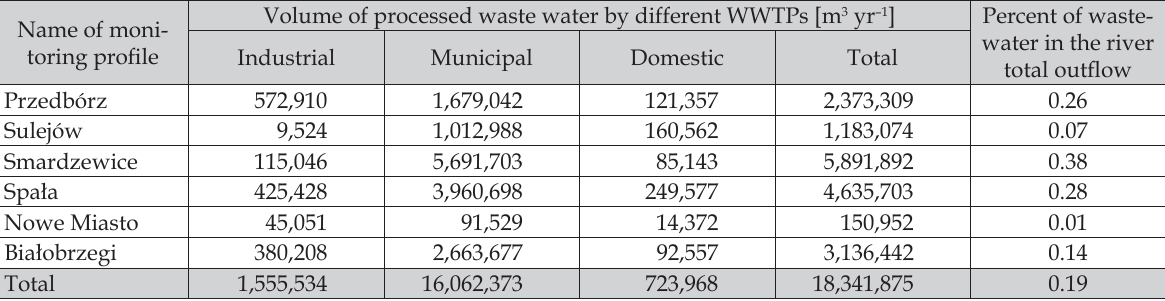
Table 2. Volume of processed wastewater by the different WWTPs and its share in the river run-off in the subcatchments (Kiedrzyńska et al. 2014)